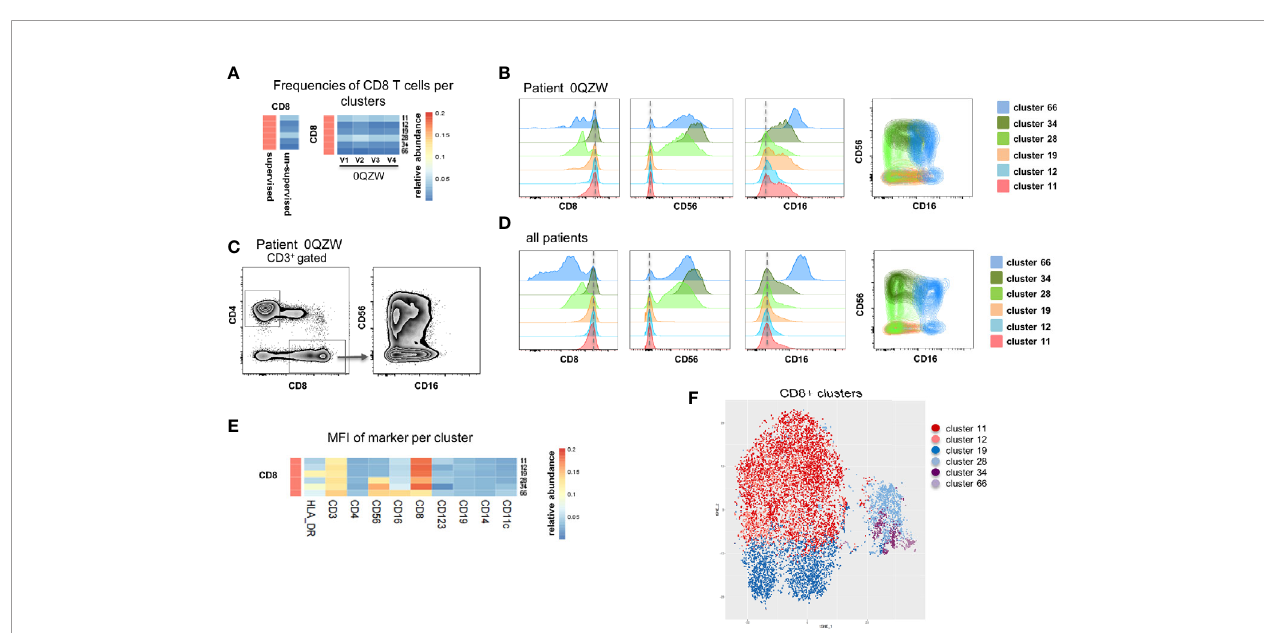
FIGURE 4 | Analysis of CD8 + subsets identi fi ed by MegaClust. (A) Comparison of the different CD8 + clusters identi fi ed by MegaClust. Left panel shows one population of CD8 + cells obtained by supervised analysis, whereas the unsupervised analysis identi fi ed 6 clusters within the CD8 + population. Four timepoints (visits, V1-V4) are shown for representative patient 0QZW. (B) Expression of CD8, CD56 and CD16 on the 6 CD8 + clusters on V1 from one representative patient. (C) Expression of CD16 and CD56 on CD8 + cells on V1 from patient 0QZW from the supervised dataset. (D) Cumulative analysis on all patients and timepoints (n=20) of the expression of CD8, CD56 and CD16 on the 6 CD8 + clusters. (E) Cumulative analysis on all patients and timepoints (n=20) of the expression level (mean fl uorescence intensity, MFI) of different markers on all CD8 + cell clusters. (F) tSNE of all CD8+ cell clusters identi fi ed with Megaclust. The NKT-like cell clusters 28, 34.and 66 are clearly separated from the remaining CD8 T cell clusters.